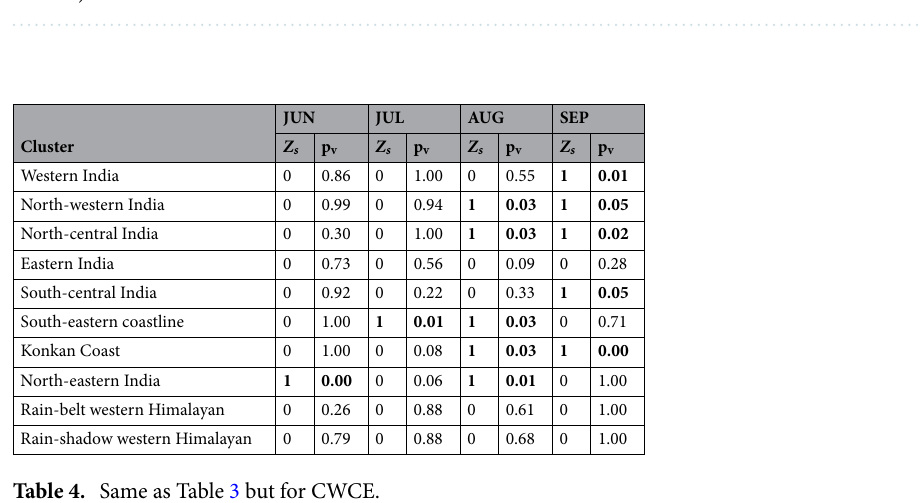
Table 3. A two-sample KS test result for the spatial extent of CDHE before and after 1976 for each homogenous region. H is the hypothesis (i.e. two samples are from the same underlying continuous population; p v is the p-value corresponding to H; H = 0 (1) state hypothesis is not rejected (rejected) at the 5% significance level; Bold text represent significant values greater than 95% confidence level (p-value ≤ 0.05, see Text S2).